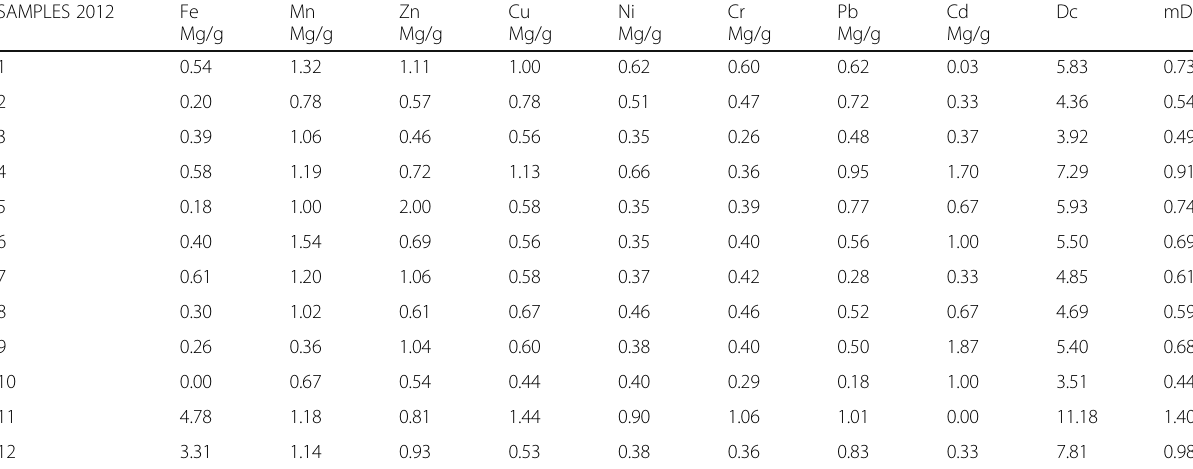
Table 12 Contamination factor, degree contamination, and modified degree contamination for 2012 SAMPLES